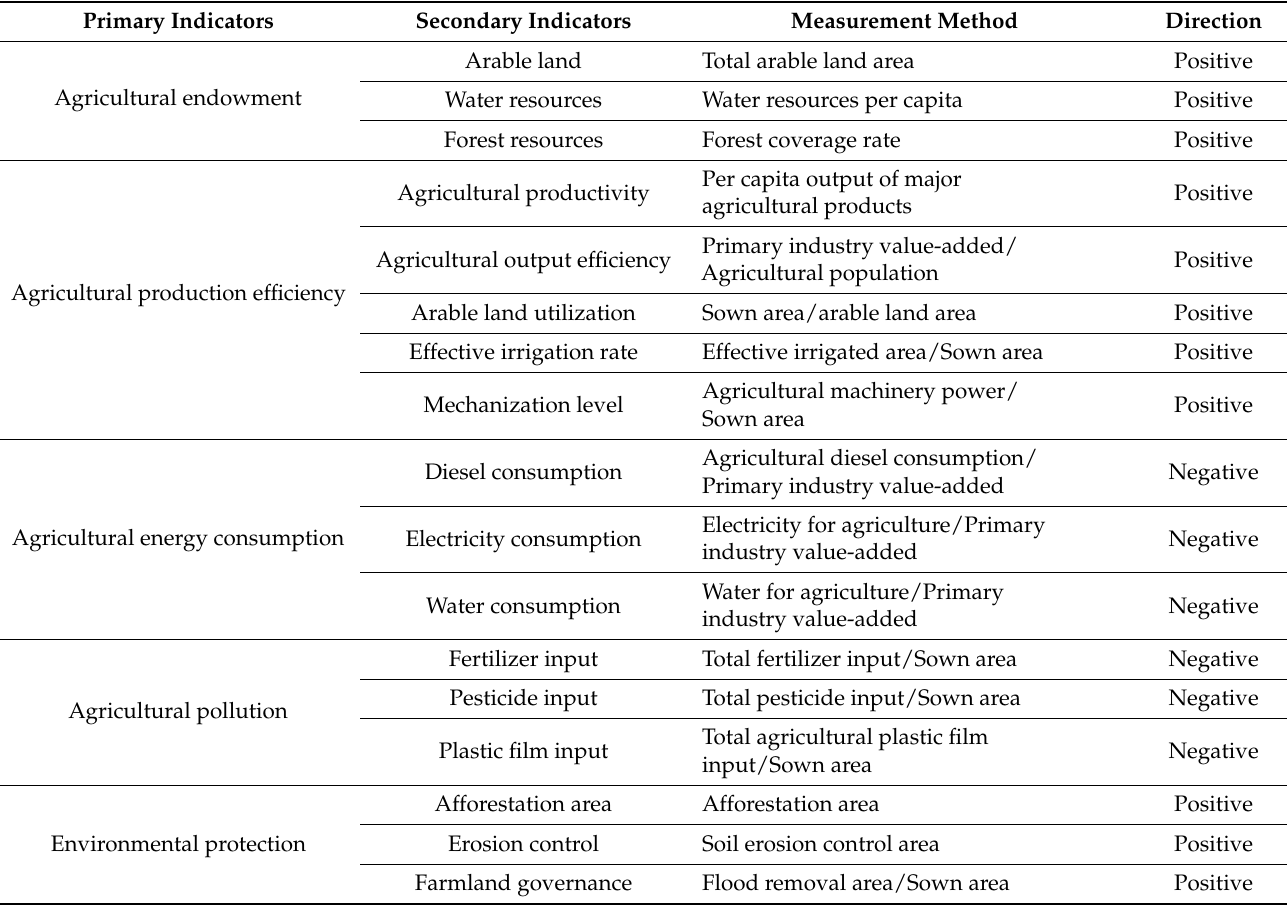
Table 1. Calculation of green agricultural development (GAD)